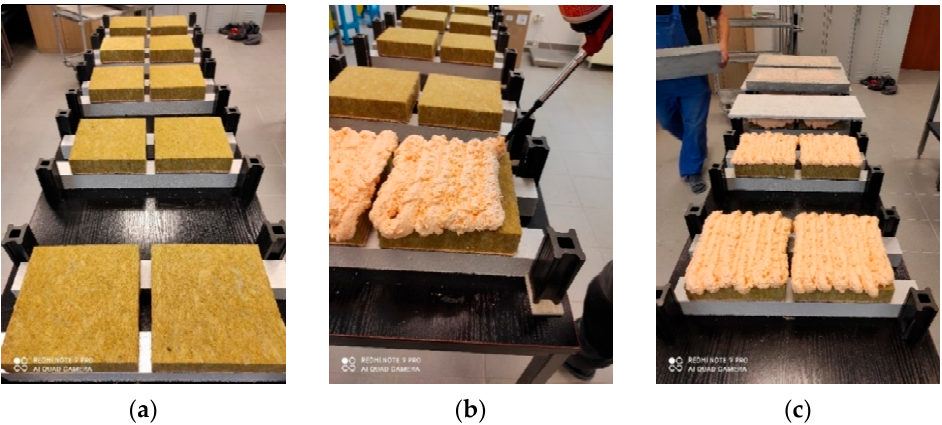
Figure 2. Preparation of samples for bond strength tests ( a ) MW prepared for adhesion, ( b ) appli- cation of adhesive to MW, and ( c ) bonding. tion of adhesive to MW, and ( c )